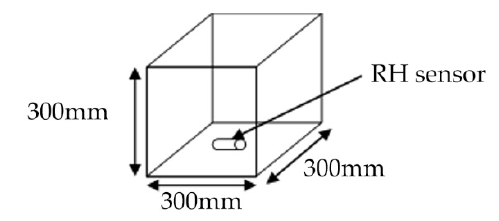
Figure 6. Diagram of experiment specimen and sensor set up.